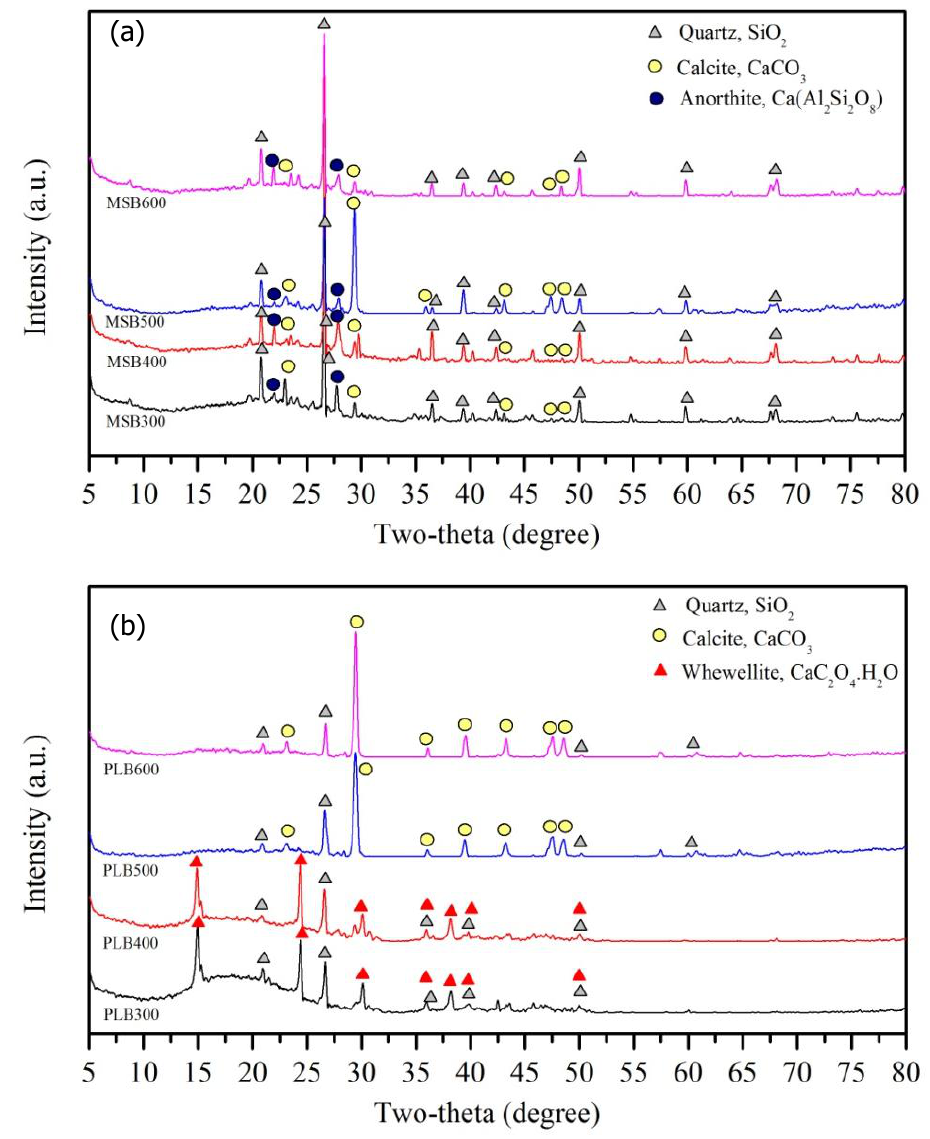
Figure 4. X-ray diffraction (XRD) patterns of MSB ( a ) and PLB ( b ).